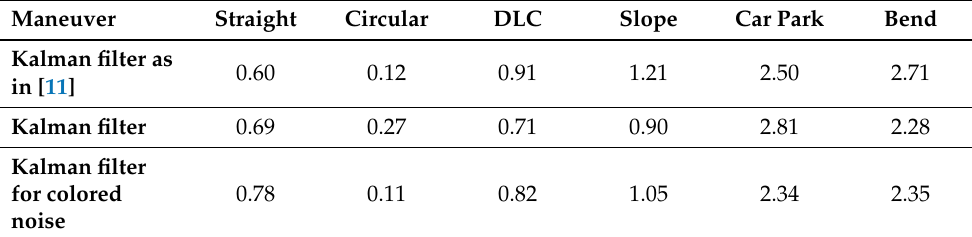
Table 5. Root mean square estimation errors for the three estimation algorithms on the six scenarios (in degrees).